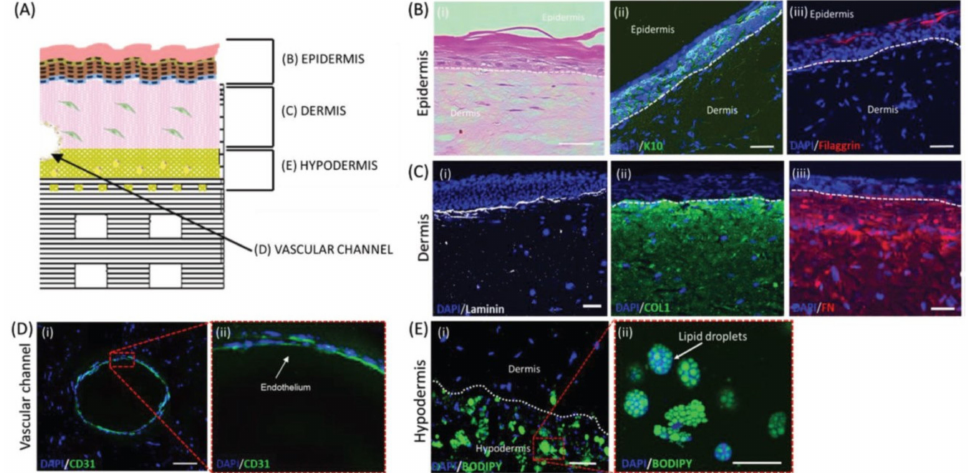
Figure 18. Histological analyses representing skin tissue maturation in in vitro environment. ( A ) Illustration of each zone of epidermis, dermis, hypodermis, and vascular channel. ( B ) Epidermis stratified (H&E staining) and stained with keratin 10 (K10) and filaggrin representing early differenti- ation and late differentiation of epidermis, respectively. ( C ) Dermis imaged with protein markers representing epidermal–dermal junction (Laminin) and secreted ECM components (COL1: collagen type I and FN: fibronectin). ( D ) Vascular channel in the mature 3D human skin equivalent stained with CD31 demonstrating the presence of endothelial cells. ( E ) Hypodermis stained with BODIPY representing lipid droplets of adipocytes (Scale bars: 50 µ m). Reproduced from [249] with permission from John Wiley and Sons,